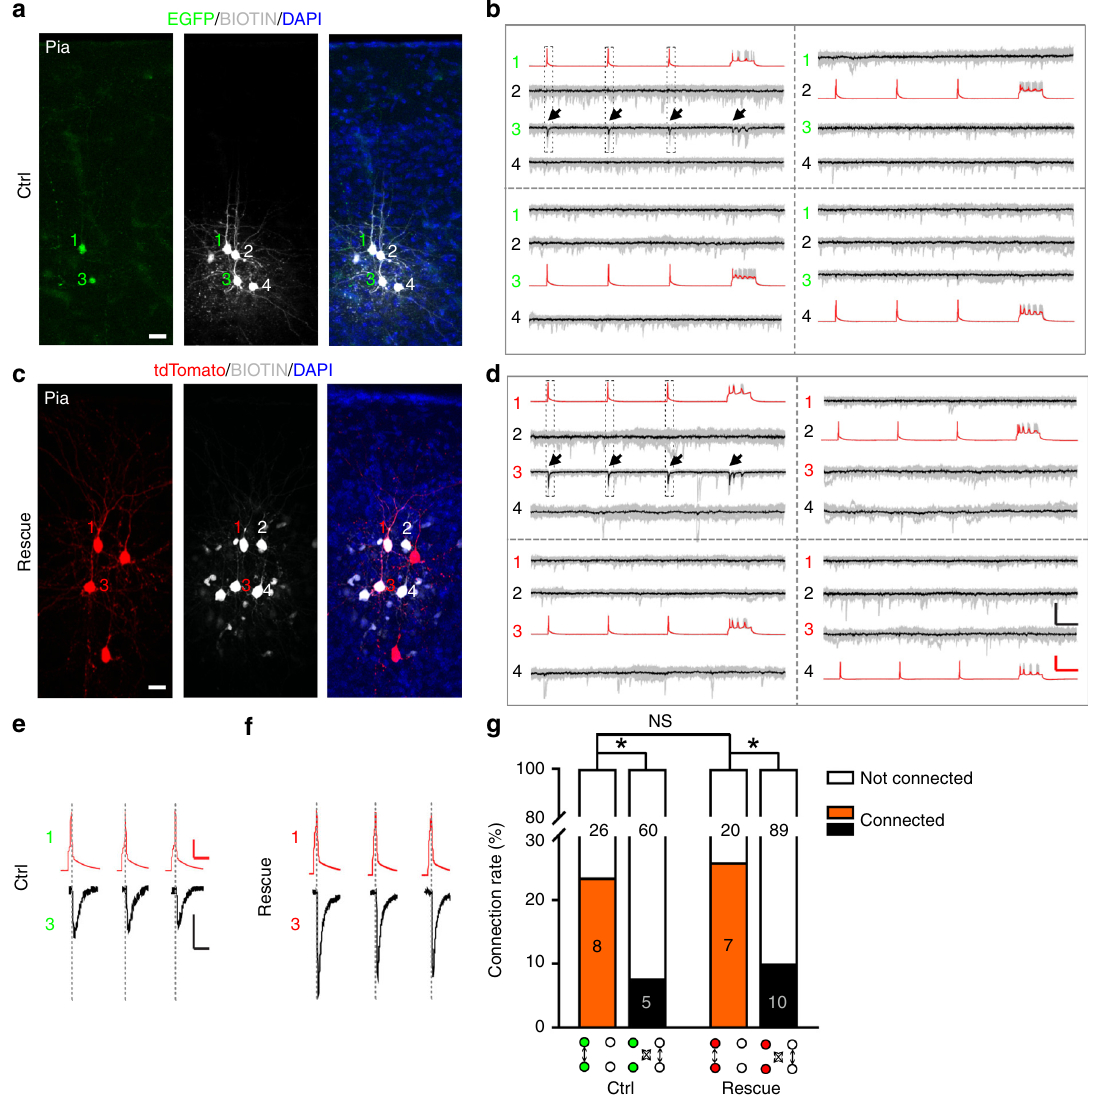
Fig. 7 PCDH19 rescues the preferential chemical synaptic defect. a , c Representative confocal images of two radially situated sister excitatory neurons in a control clone expressing EGFP (1 and 3, green, a ) or in a rescue clone expressing tdTomato/PCDH19/Cre (1 and 3, red, c ) and two adjacent non-EGFP or non-tdTomato-expressing non-sister excitatory neurons (2 and 4) in the Tbr2 fl / fl mice. Scale bars: 50 μ m. b , d Example traces of four excitatory neurons recorded in ( a ) and ( c ), respectively. Brief and long duration depolarizing currents were injected into one of the four neurons to elicit action potentials (presynaptic, red) and postsynaptic responses were monitored in the other three neurons. Individual traces are shown in gray and average traces are shown in black. Arrows indicate the reliable postsynaptic responses in control or rescue sister excitatory neuron 3 elicited by the presynaptic action potentials in control or rescue sister excitatory neuron 1. Scale bars: 100 mV (red), 20 pA (black), and 200 ms. e , f Zoom-in traces of the presynaptic action potentials and postsynaptic responses between EGFP-expressing control or tdTomato-expressing rescue sister excitatory neurons 1 and 3 in ( b ) and ( d ), respectively. Scale bars: 25 mV (red), 10 pA (black), and 25 ms. g Summary of the frequency of chemical synaptic connections between sister excitatory neurons and their nearby non-sister excitatory neurons in control and rescue clones. The numbers of the recorded pairs are shown in the bar graph (* P < 0.05; NS not signi fi cant; chi-square